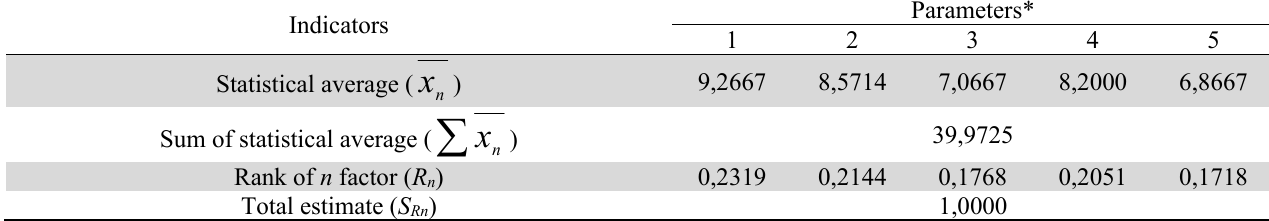
Relative importance of the enterprise’s competitiveness